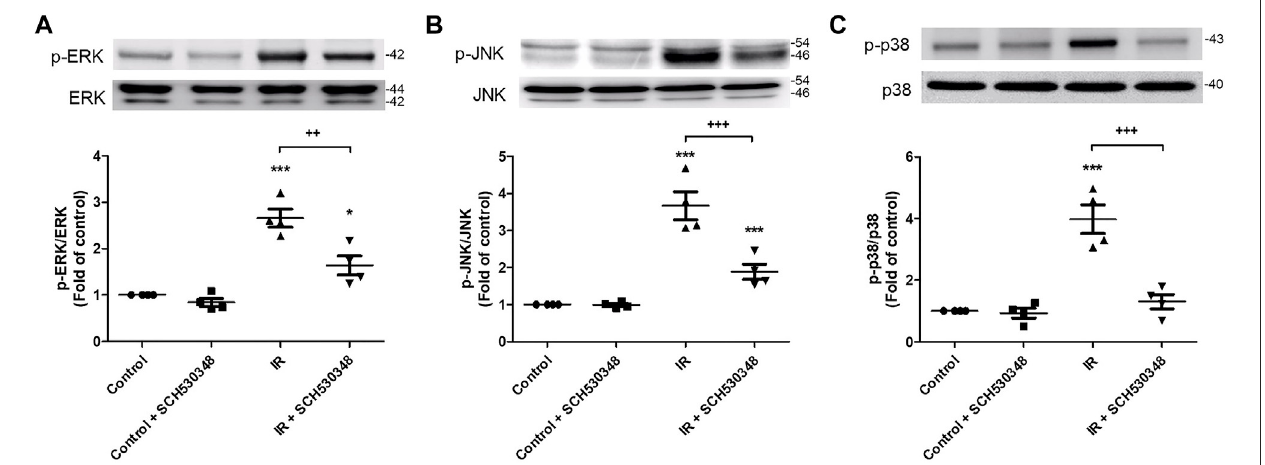
FIGURE 9| SCH530348 attenuated IR-induced MAPK signaling activation. Western blot analysis showing that the levels of (A) phosphorylated ERK, (B) JNK and (C) p38 were upregulated in lung tissue after IR injury compared with those of the control group. The levels of phosphorylated ERK, JNK and p38 were downregulated afterSCH530348treatmentfollowingIRinjury.Thedataareexpressedasthemean ± SD( n (cid:1) 4pergroup).* p < 0.05,*** p < 0.001,comparedwiththecontrolgroup;++ p < 0.01, +++ p < 0.001, compared with the IR group.